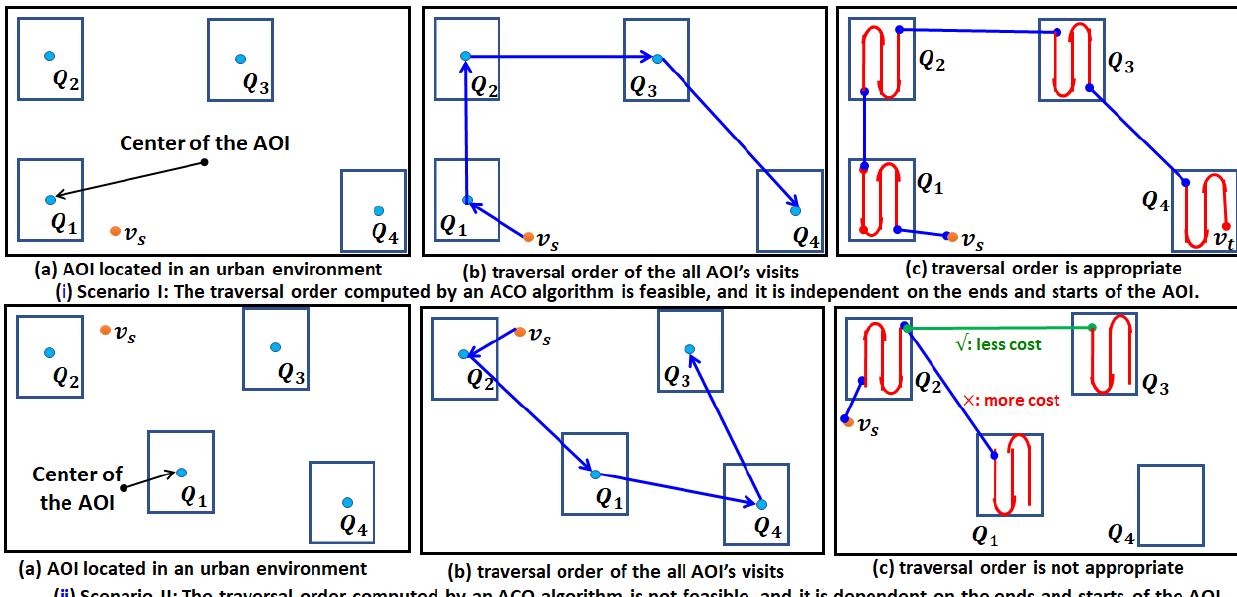
Figure 10. Overview of two cases regarding the feasibility of traversal order (e.g., order is feasible ( i ), and is infeasible ( ii